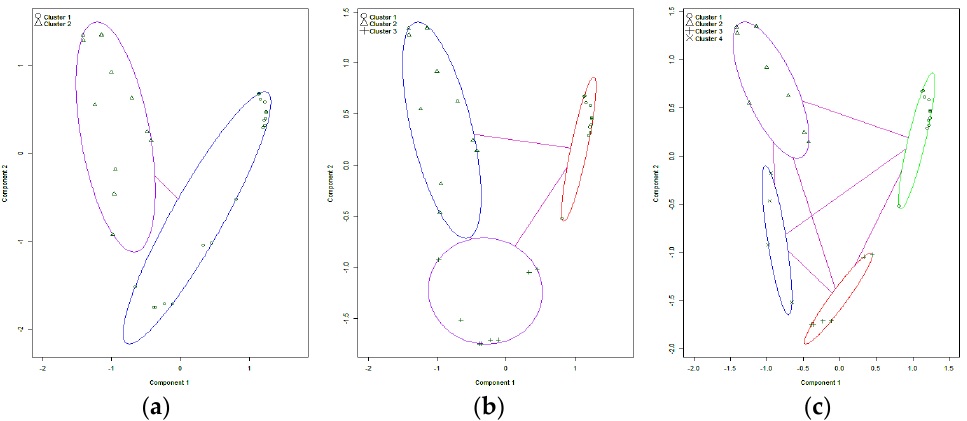
Figure 1. Bivariate Cluster Plots of Partitioning Around Medoids. ( a ) Bivariate Cluster Plot of PAM for k = 2. ( b ) Bivariate Cluster Plot of PAM for k = 3. ( c ) Bivariate Cluster Plot of PAM for k = 4.